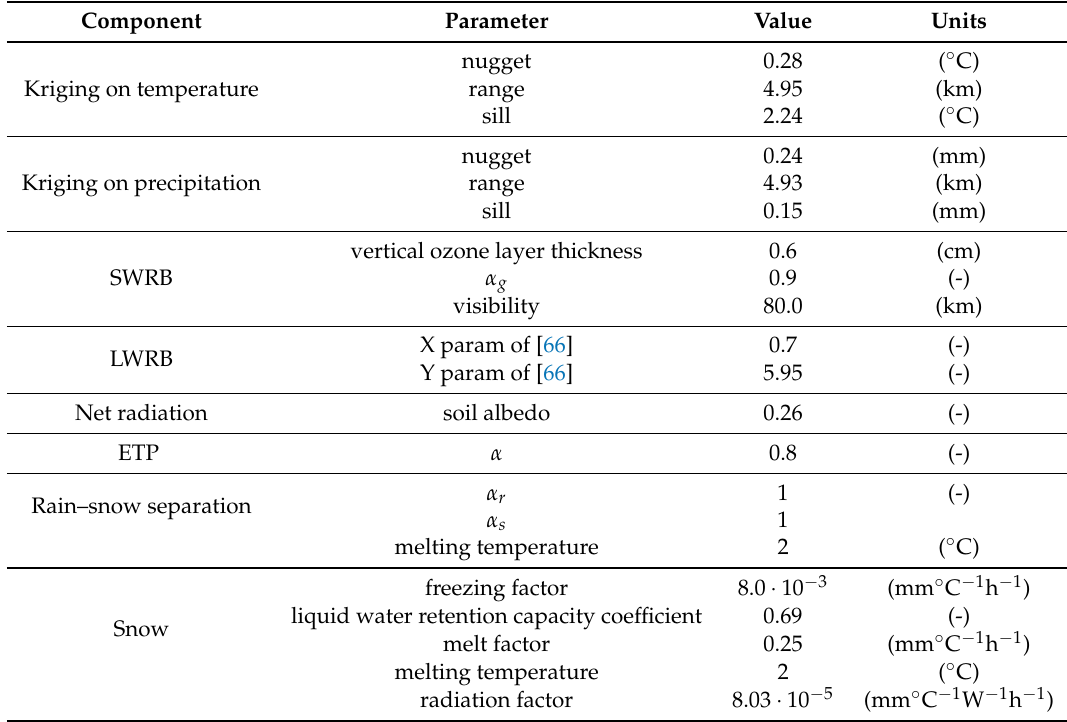
Table 3. Model parameter of the Kriging, shortwave radiation (SWRB), longwave radiation (LWRB), net radiation, potential evapotranspiration (ETP), rain–snow separation, snow, and canopy components, which were fixed for all the HRUs.